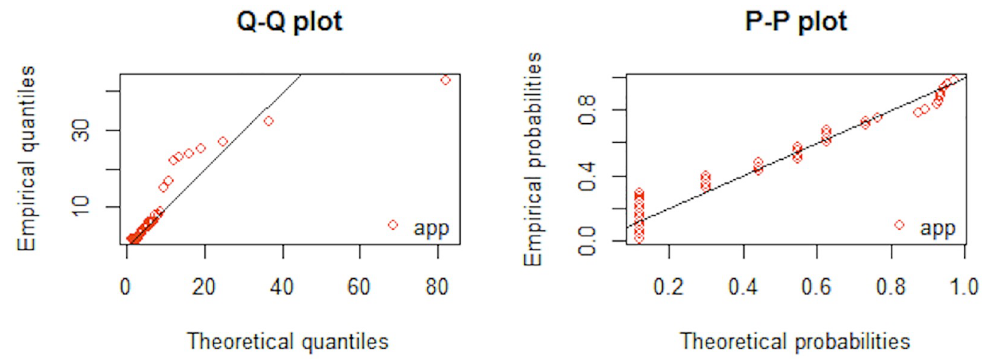
Fig 5. QQ-plot and PP-plot of APP distribution for dataset 1.